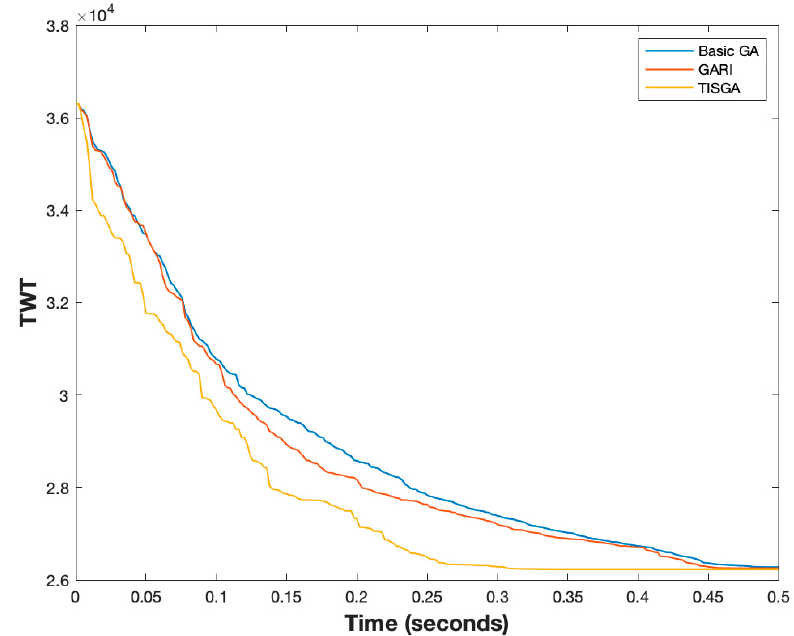
Figure 24. TWT value vs. computation time for TISGA, GARI and basic GA, for instance, with 50 jobs.